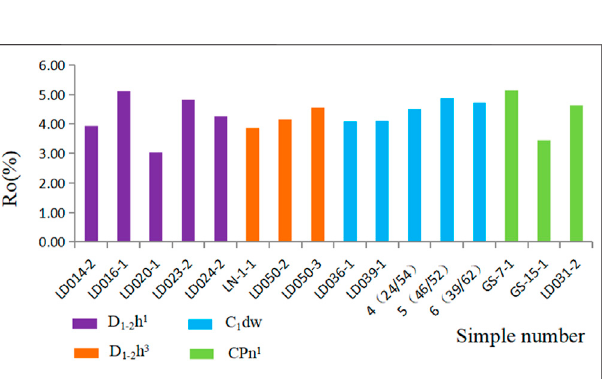
Frontiers in Earth Science |